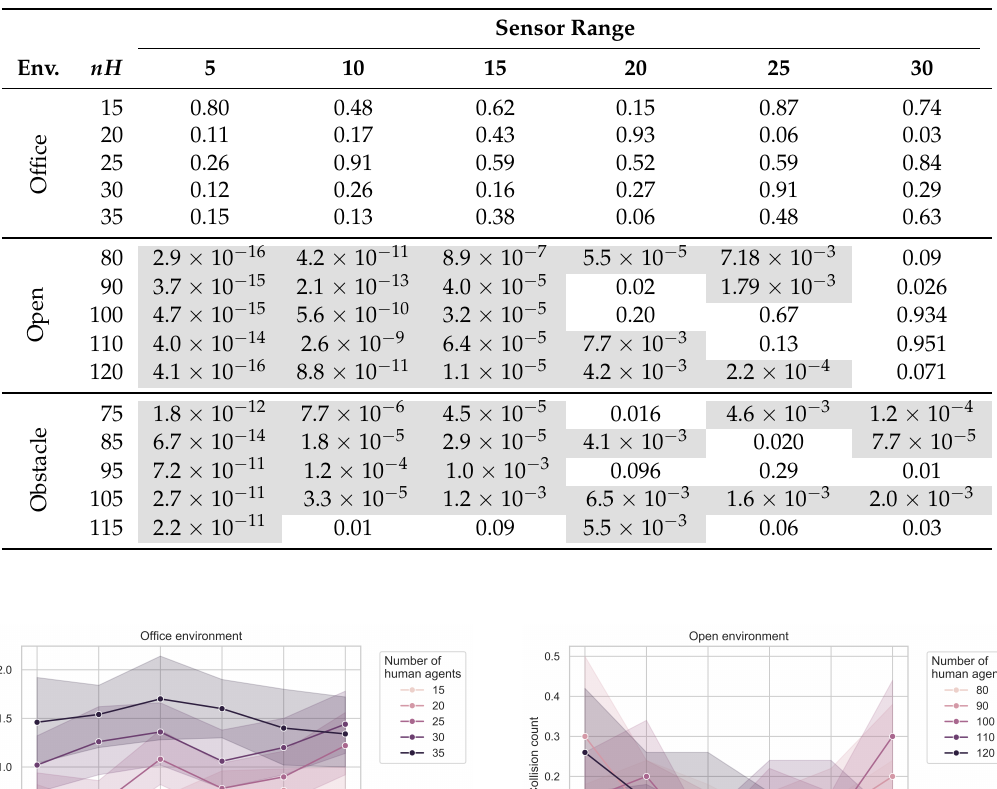
Table 2. p -values from Wilcoxon rank-sum tests comparing ideal navigation times from the baseline to the performance summarised in Figure 4. nH is shorthand for number of simulated human agents . Significant values after Bonferroni correction are highlighted in grey.